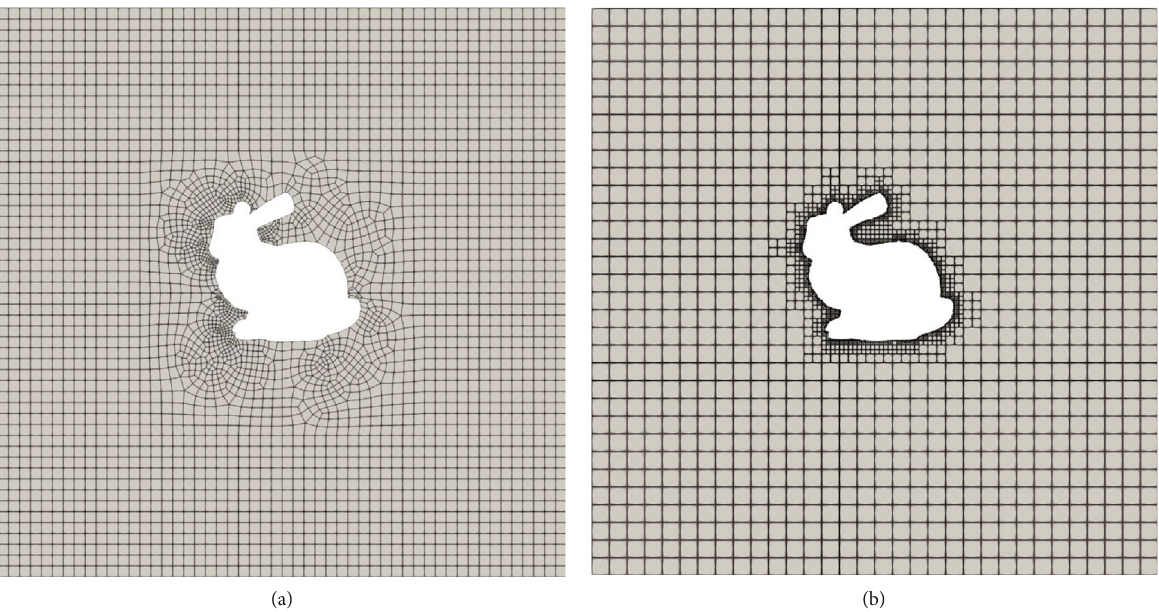
Figure 11: Meshes of a square plate with a Stanford bunny cavity: (a) Abaqus mesh; (b) quadtree mesh.